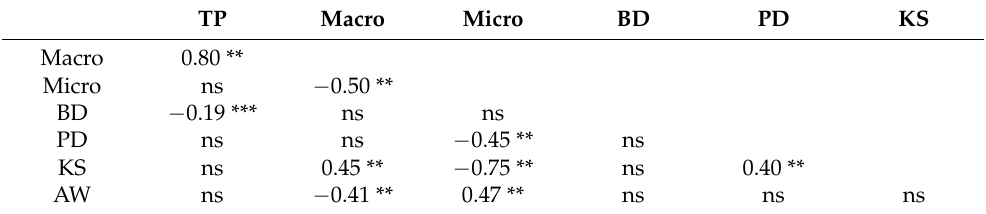
Table 7. Pearson’s correlation between the soil physical–hydric properties of Quartzipsamments of the Southwest of Rio Grande do Sul State, southern Brazil. TP Macro Micro BD PD KS Macro 0.80 **